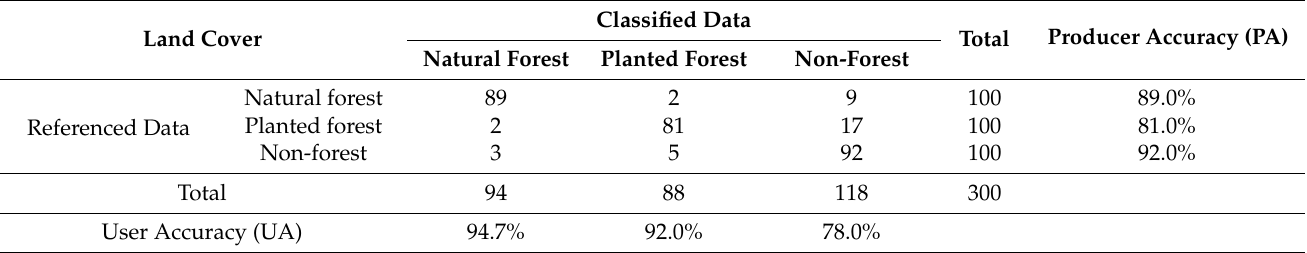
Table 2. Confusion matrix of the NHAR natural/planted forest maps in